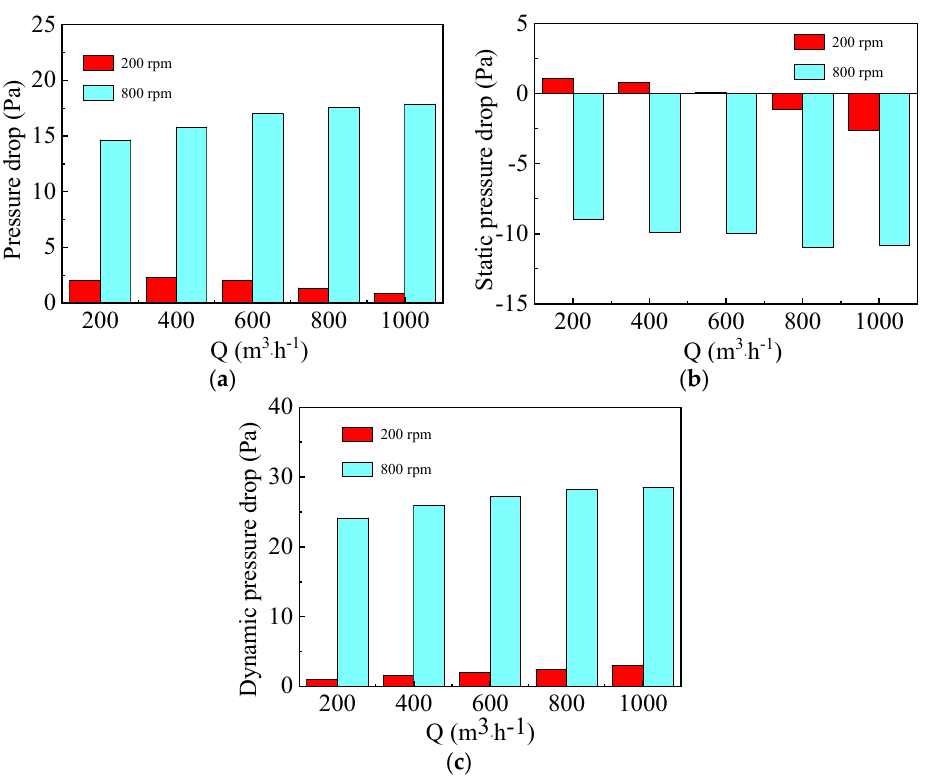
Figure 12. The effect of the gas flow rate on the pressure drop in cavity the zone B. ( a ) Pressure drop; ( b ) static pressure drop; ( c ) dynamic pressure drop.